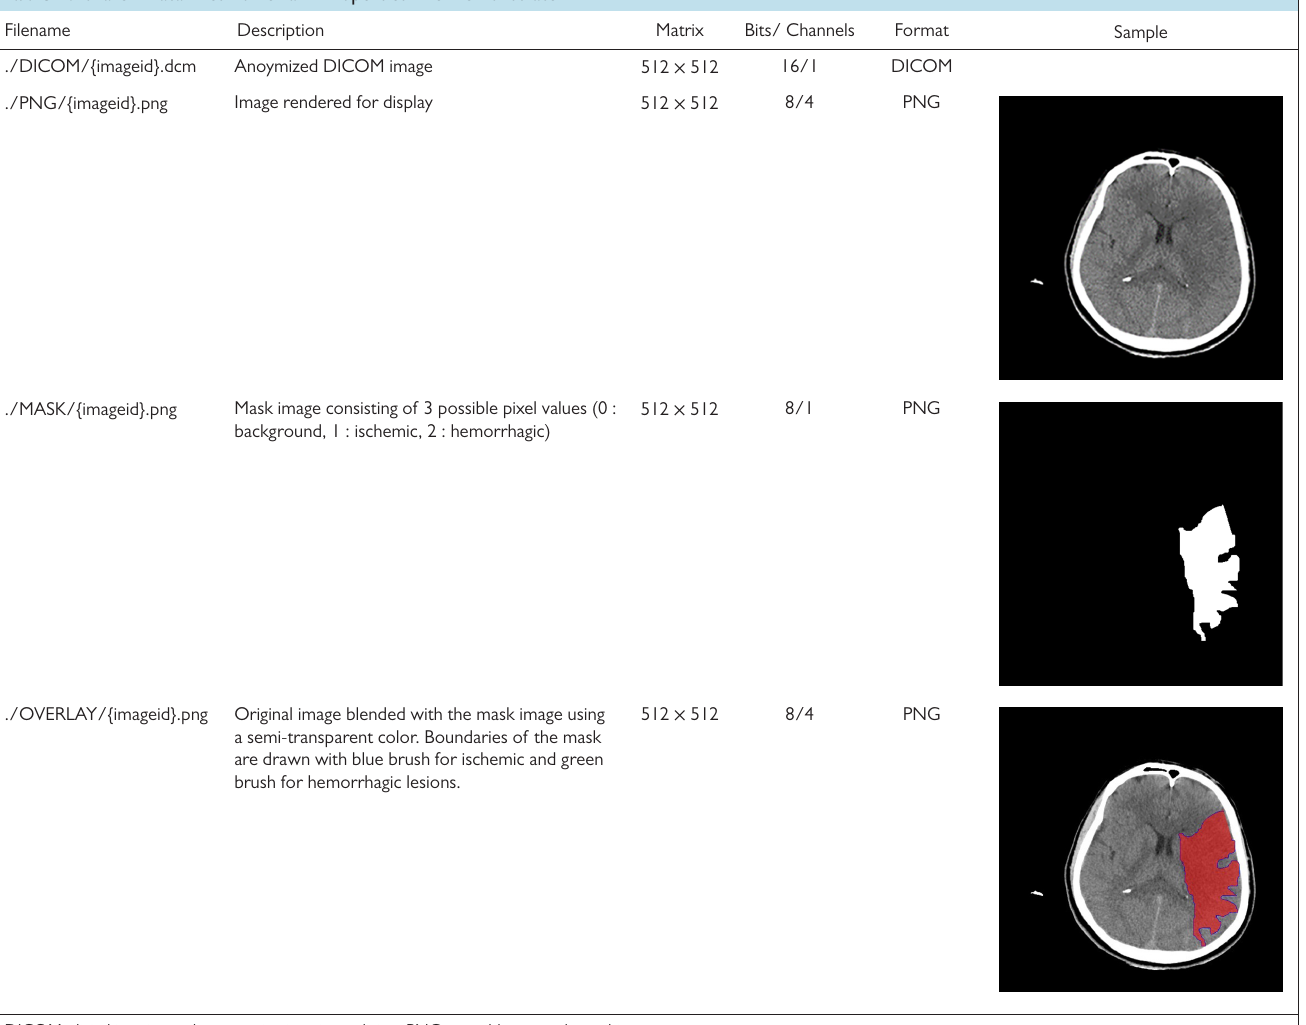
Table 4. Shared Data-Files Folder and Properties Are